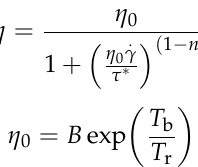
Table A1. Cross model parameters of viscosity estimation of the polypropylene used.